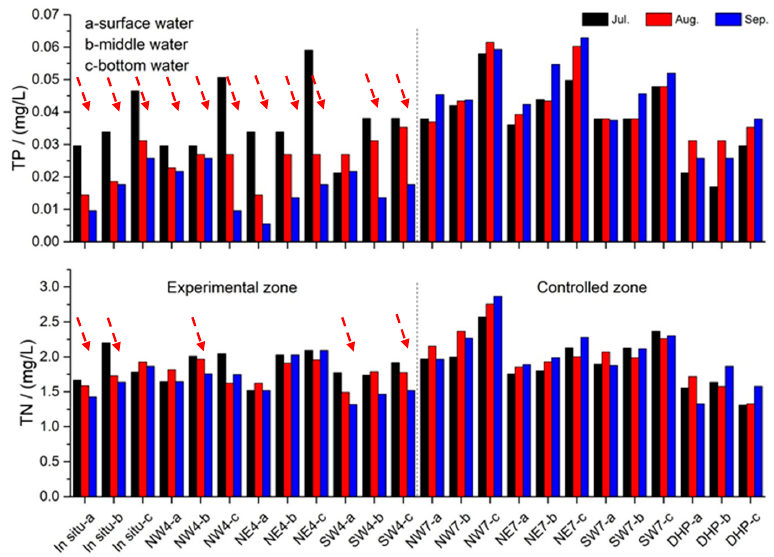
Figure 7. Variations of total phosphorus (TP) and total nitrogen (TN) in the experimental zone and the control zone.